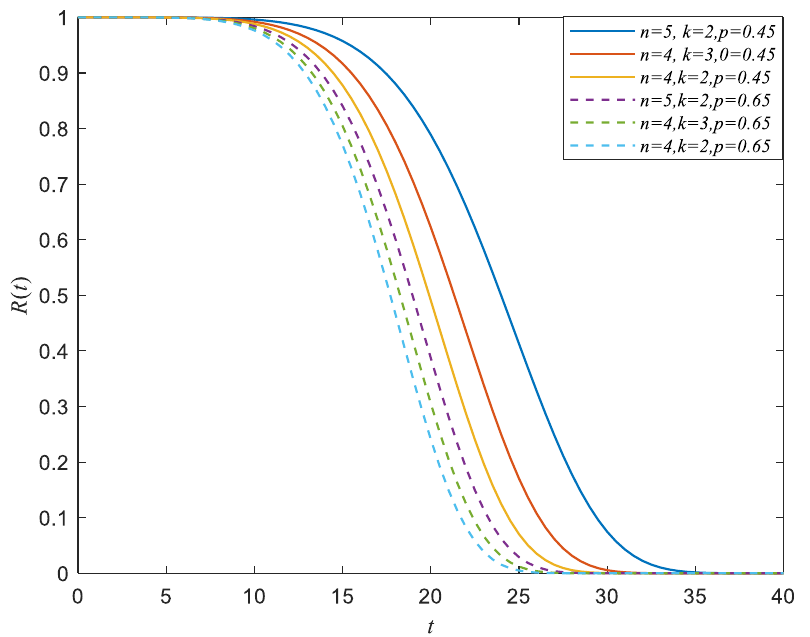
Figure 4. Simulation result of the system reliability under trigger mechanism 1.